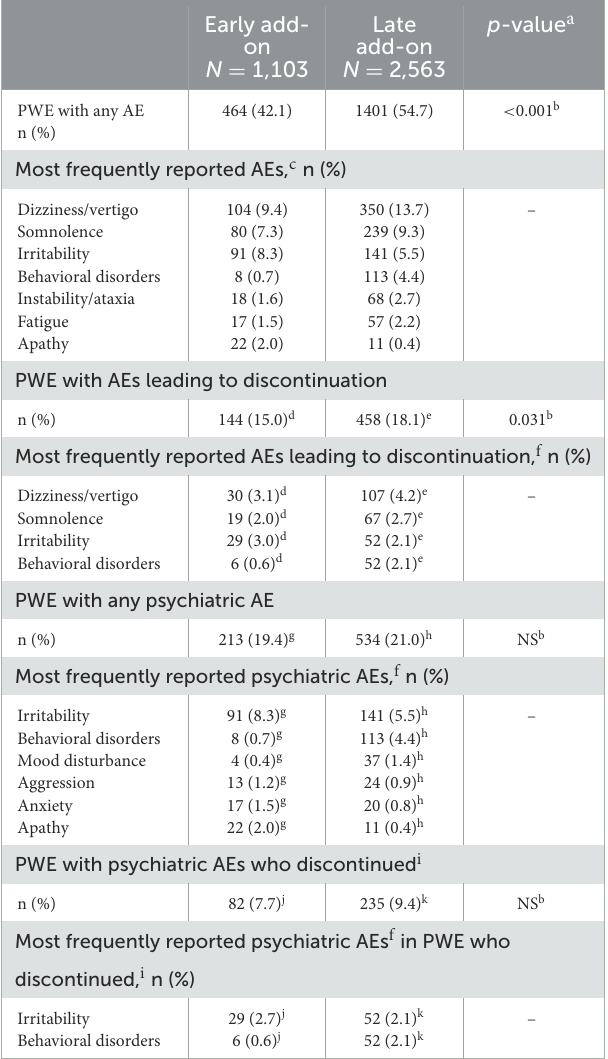
TABLE 2 Summary of safety and tolerability (tolerability